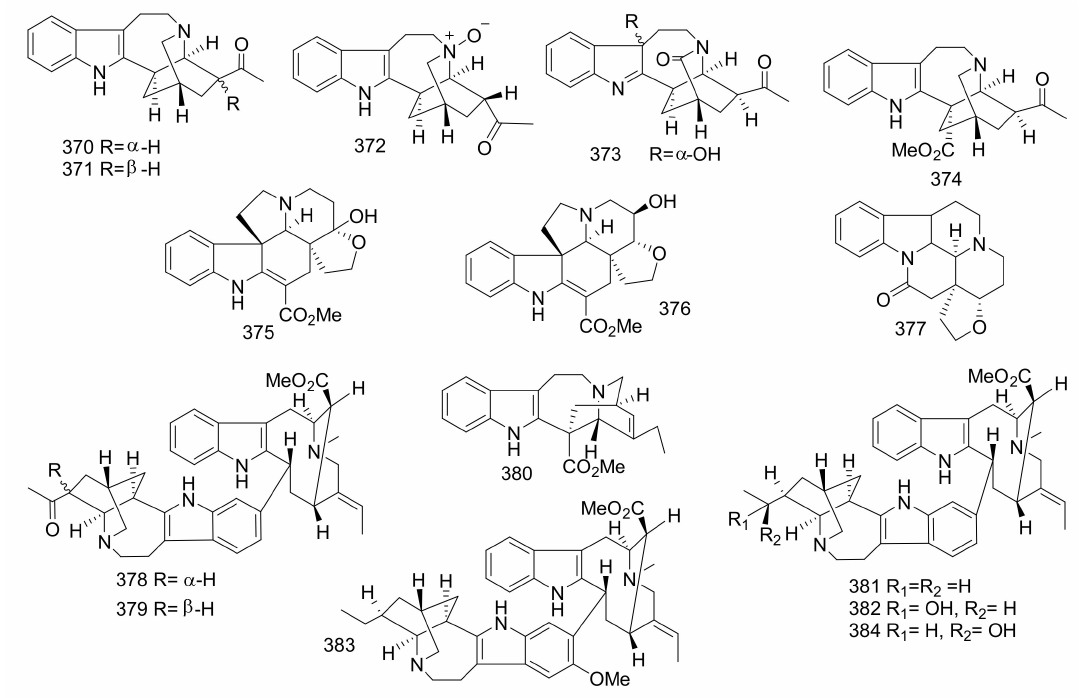
Figure 29. Compounds 370 – 384